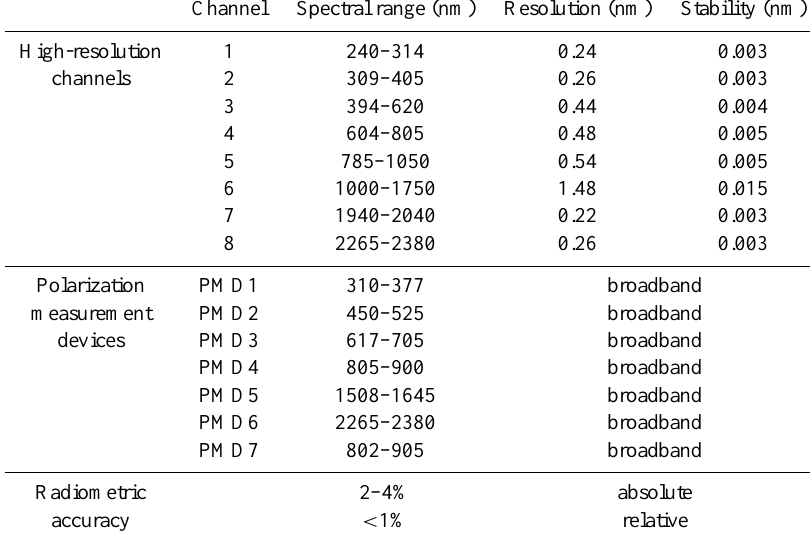
Table 1. Table of optical parameters of the SCIAMACHY instrument.